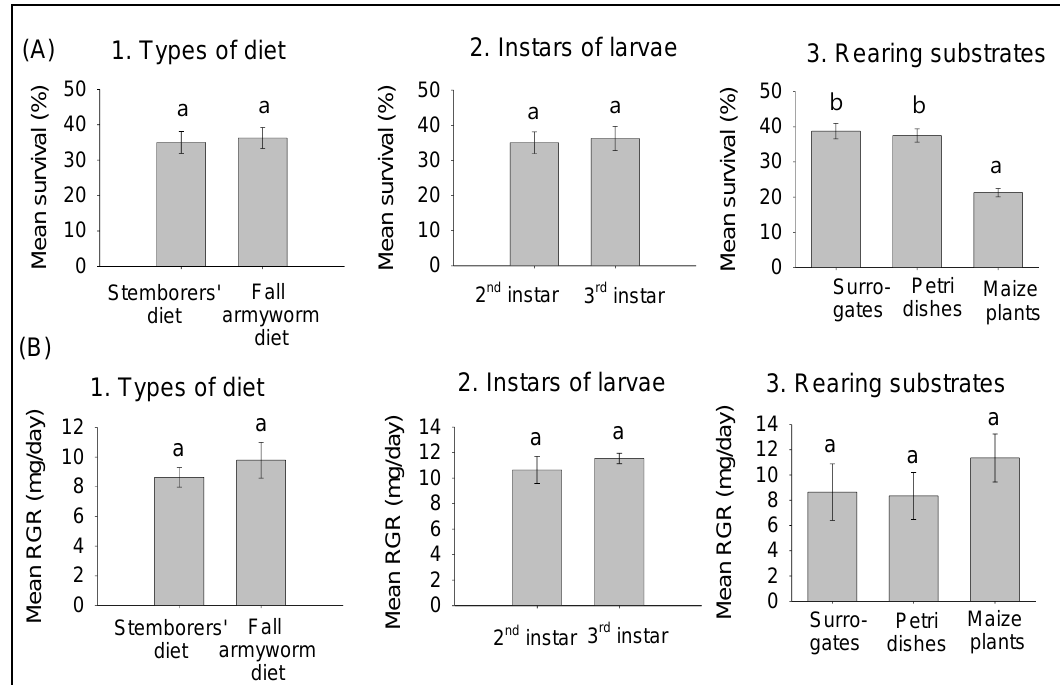
Figure 1. Effects of diet type, larval stage and rearing substrates on the survival ( A ) and relative growth rate ( B ) of fall armyworm larvae. Means (±SE) with different letters are significantly different, determined using linear model (GLM) with binomial error distribution. Significant differences were separated using Tukey’s multiple comparisons tests performed with lsmeans R package [21], following generalized linear model (GLM) with binomial errors distribution. For relative growth rate (RGR), means (±SE) were separated with lsmeans R package [21] with p-value adjustment method False Discovery Rate (FDR) [22] following analysis of variance (ANOVA) after constructing general linear models. Table 1. Result of GLM analysis comparing larval survival of each single-species at di ff erent constant temperature and at each temperature between species. Statistic Values Statistic Values Between Temperatures Between Species O.R. (95% CI)